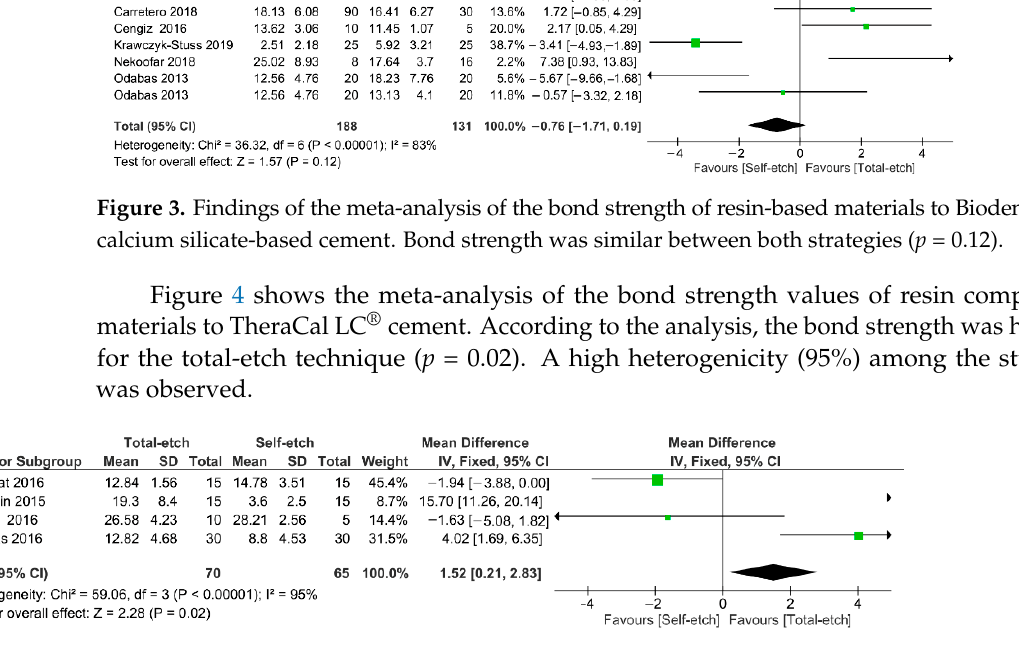
Figure 4. Findings of the meta-analysis of the bond strength of resin-based materials to TheraCal LC ® calcium silicate-based cement. Bond strength was higher for the total-etch technique ( p = 0.02). The risk of bias in the articles studied in this review is recapped in Table 2. Most of the articles included failed to meet the parameters of Single Operator, Blinded Operator, Sample Size Calculation, and Control group. The global analysis showed that the utmost of the articles included were cataloged as high and medium risk of bias. Table 2. Risk of bias assessment. (Red Code = High risk; Black code = Medium